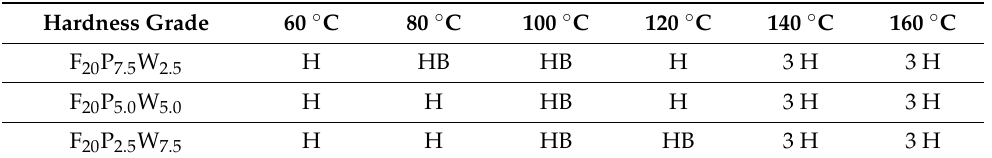
Table 5. Hardness of conductive silver paste paint films containing Ag MFs, Ag NWs, and Ag NPs at different curing temperatures.